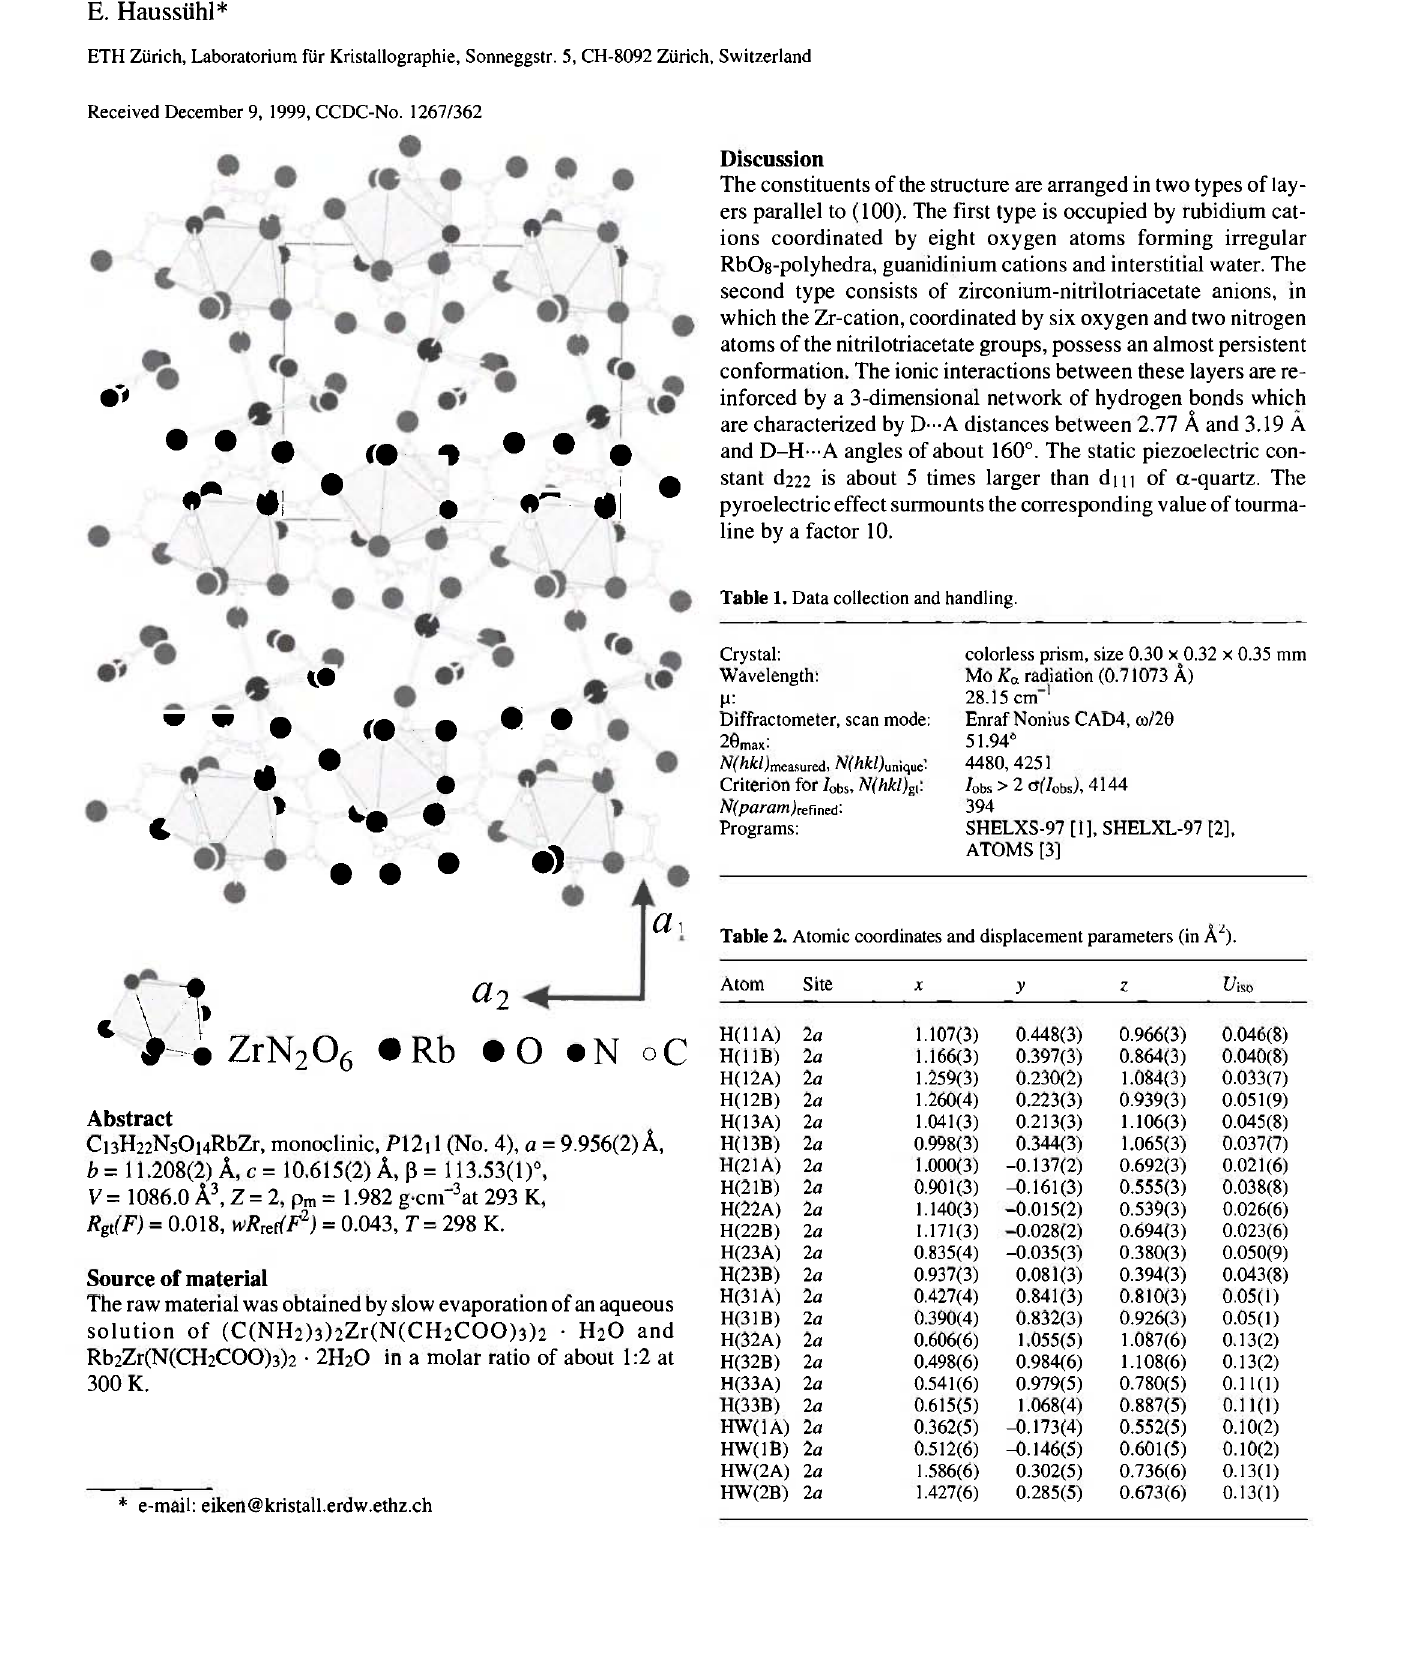
Table 1. Data collection and handling.